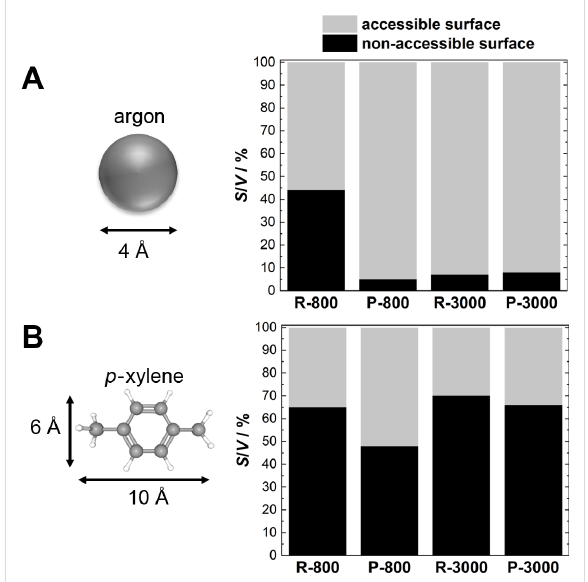
Figure 5: (A) Ratios of the surface areas are based on Ar physisorp- tion and SANS analysis (empty samples) ( S Phys.,Ar / S SANS,empty ). (B) Ratios based only on SANS analysis of the empty and DPX-filled carbon samples ( S SANS,filled / S SANS,empty ).